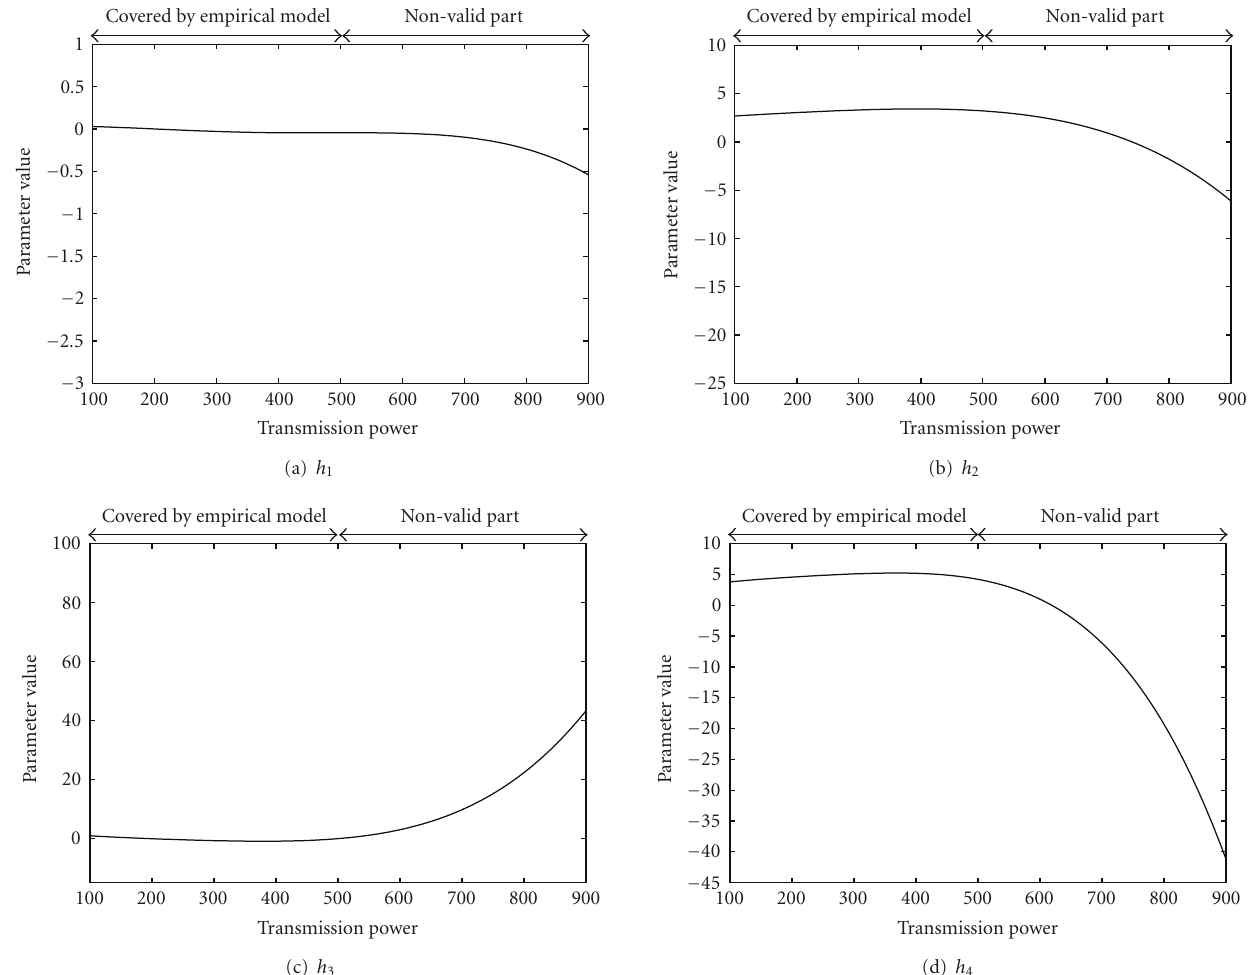
Figure 5: Values of the fitting functions h 1 through h 4 depending on the transmission power ψ (the remaining configuration parameters f and δ are both set to